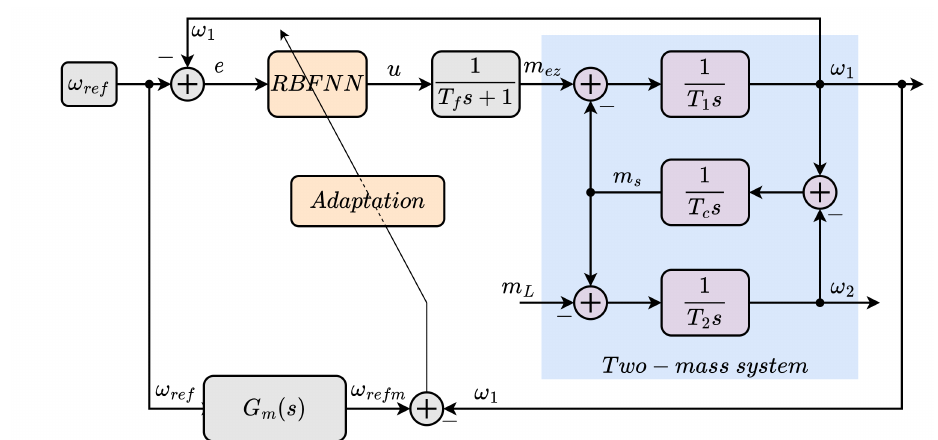
Figure 2. The control structure with the adaptive RBFNN speed controller applied to the two- mass